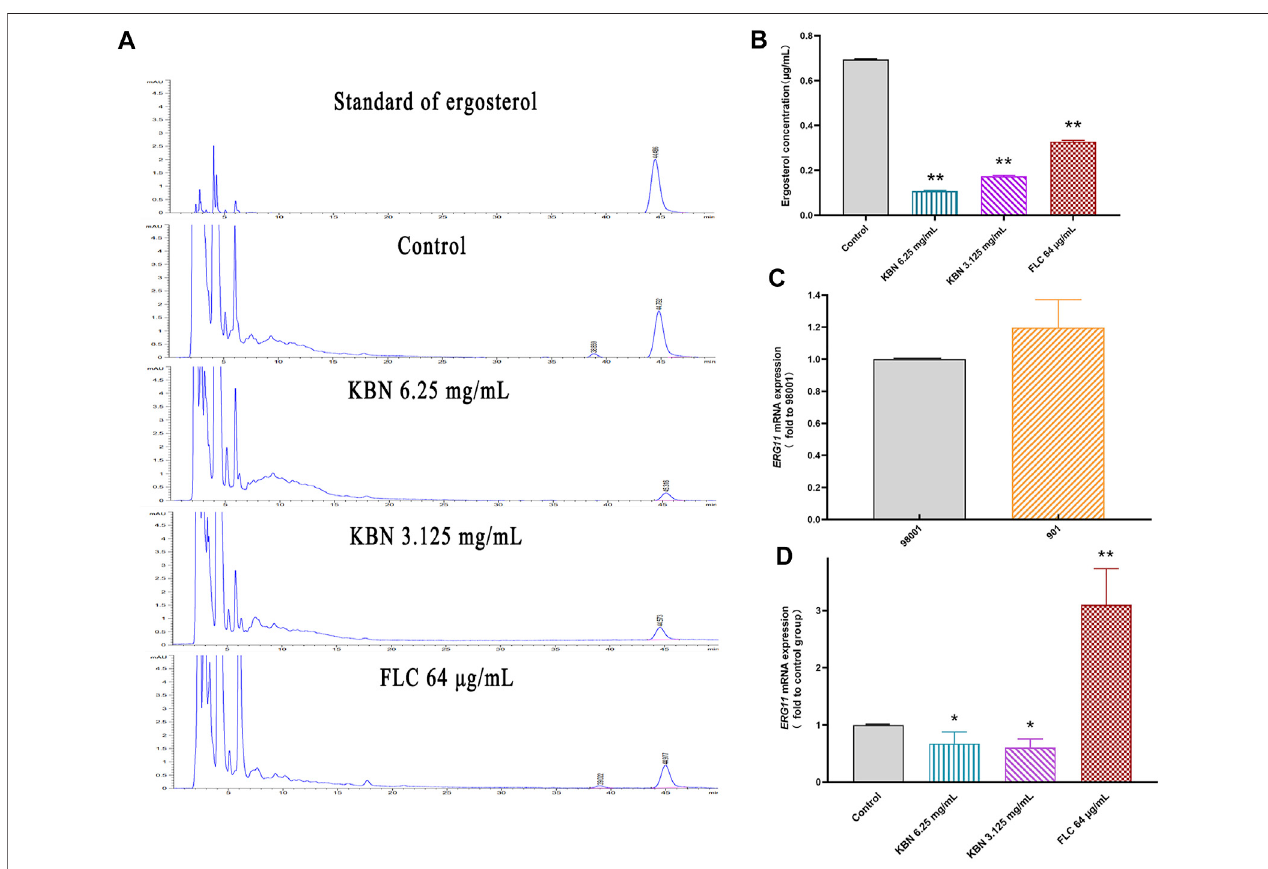
FIGURE 7 | Effect of KBN on ergosterol content of FLC-resistant C. albicans 901 and expression of related gene ERG11 . (A) Quantitative analysis of cellular ergosterol in FLC-resistant C. albicans 901 treated with KBN or FLC for 48 h by HPLC. (B) Ergosterol content of cells treated with KBN. Values were described as ergosterol ( μ g/mL). (C) The expression of ergosterol synthesis gene ERG11 in FLC-resistant C. albicans 901 and sensitive C. albicans 98001. (D) Changes in the expression of ergosterol synthesis gene ERG11 in FLC-resistant C. albicans 901 treated with KBN or FLC for 6 h. The gene was examined by RT-PCR with gene- speci fi c primers. All values are expressed as the mean ± SD of triplicate assays. * p < 0.05 versus control group, ** p < 0.01 versus control group.